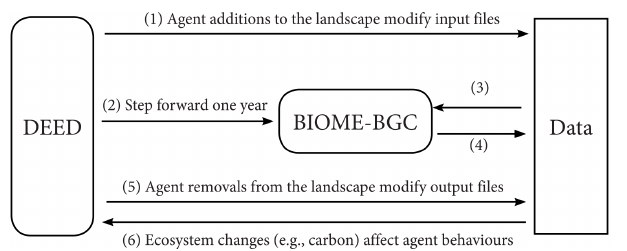
Figure 4. Structure of feedback between DEED and BIOME-BGC. Numbers indicate the sequence of steps in a single time step of a coupled model run. (3) BIOME-BGC retrieves site-characteristic and climate data as well as initial conditions for the next time step comprising biogeochemical pool values among other information. (4) Results of vegetation growth and changes to biogeochemical pools are written back for manipulation by the